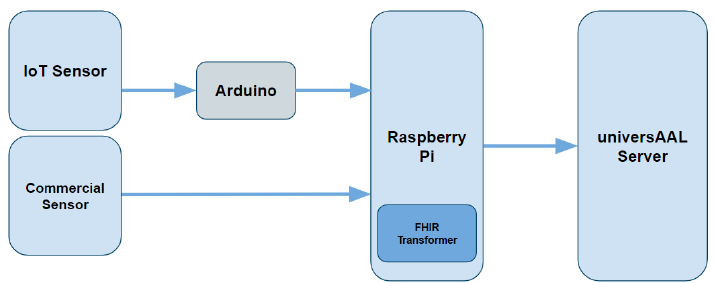
Figure 2. Architecture of the IoT-Health care